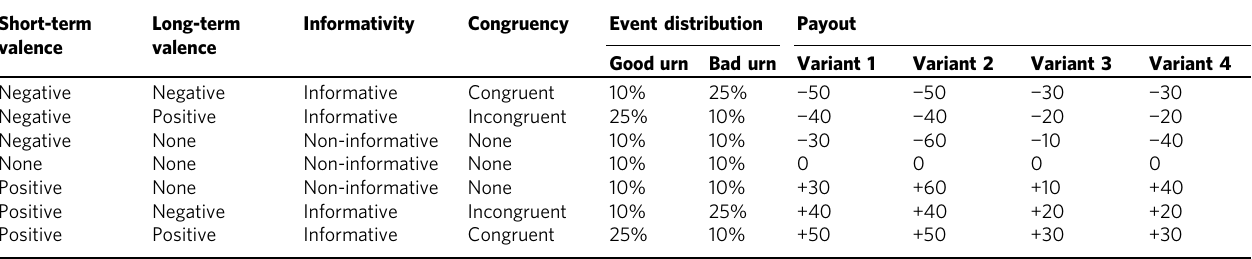
Table 1 Event structure of the